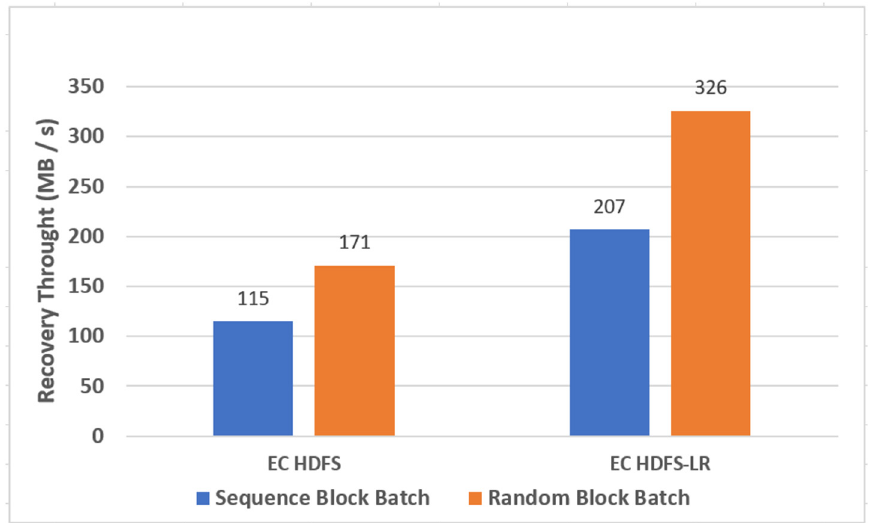
Figure 24. Performance comparison according to the block placement technique between the EC HDFS and the EC HDFS-LR.